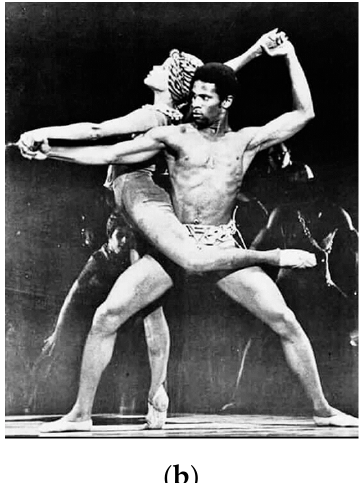
Figure 8. ( a ) Catherine Zuaznabar in L’Amour et la Danse from the Ballet for Life. 2004. Published with the kind permission of Catherine Zuaznabar; ( b ) Caridad Martinez and Andrés Williams in the Estirpes cubanas at the Gran Teatro de La Habana, Federico Garcías Lorca. After 1979. Published with the kind permission of Caridad Martinez.